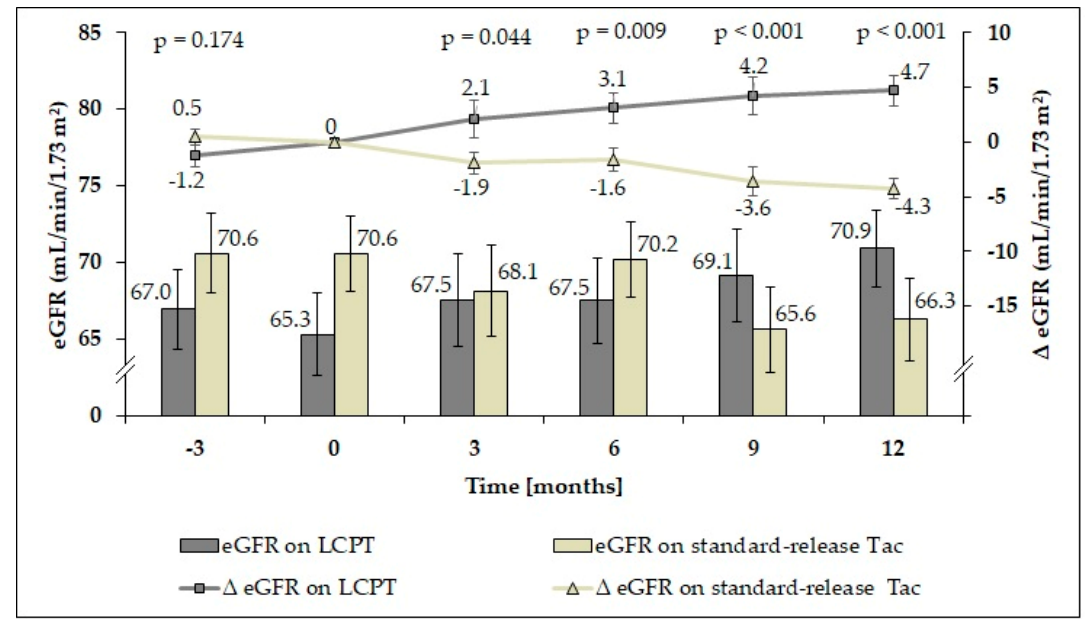
Figure 3. Glomerular filtration rate (eGFR; mL / min / 1.73 m 2 ) over time and the di ff erence from baseline at each time point ( ∆ eGFR ± SEM) in each study group. Improved renal function with a significantly increased mean ∆ eGFR was already observed 3 months after conversion to LCPT (dark grey). p -values reflect comparison of ∆ eGFR between the study groups.